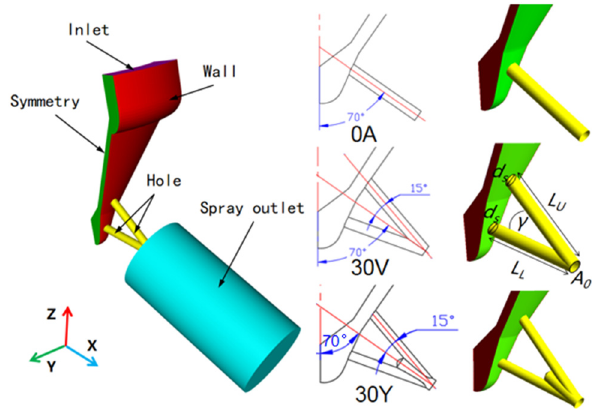
Figure 1: The geometry model of the nozzle and boundary de fi